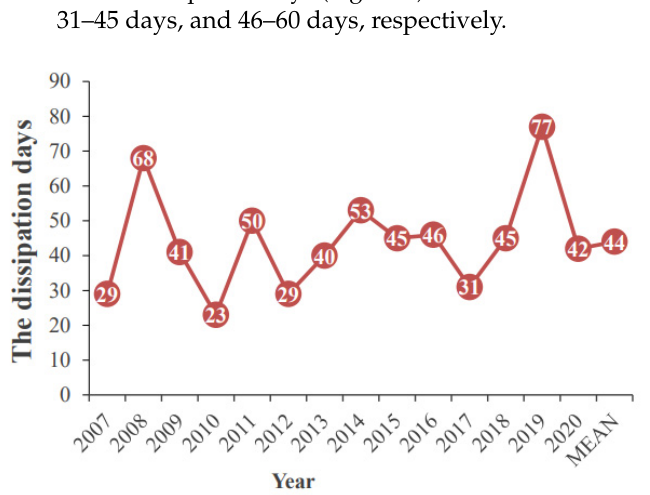
Figure 7. The dissipation days from 2007 to 2020.